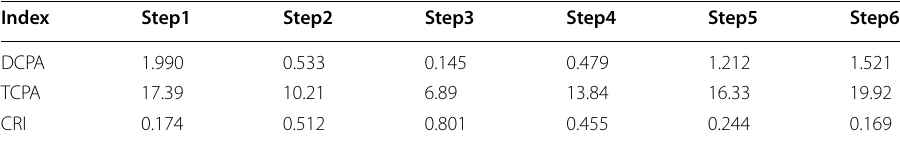
Table 2 Collision risk correlation index